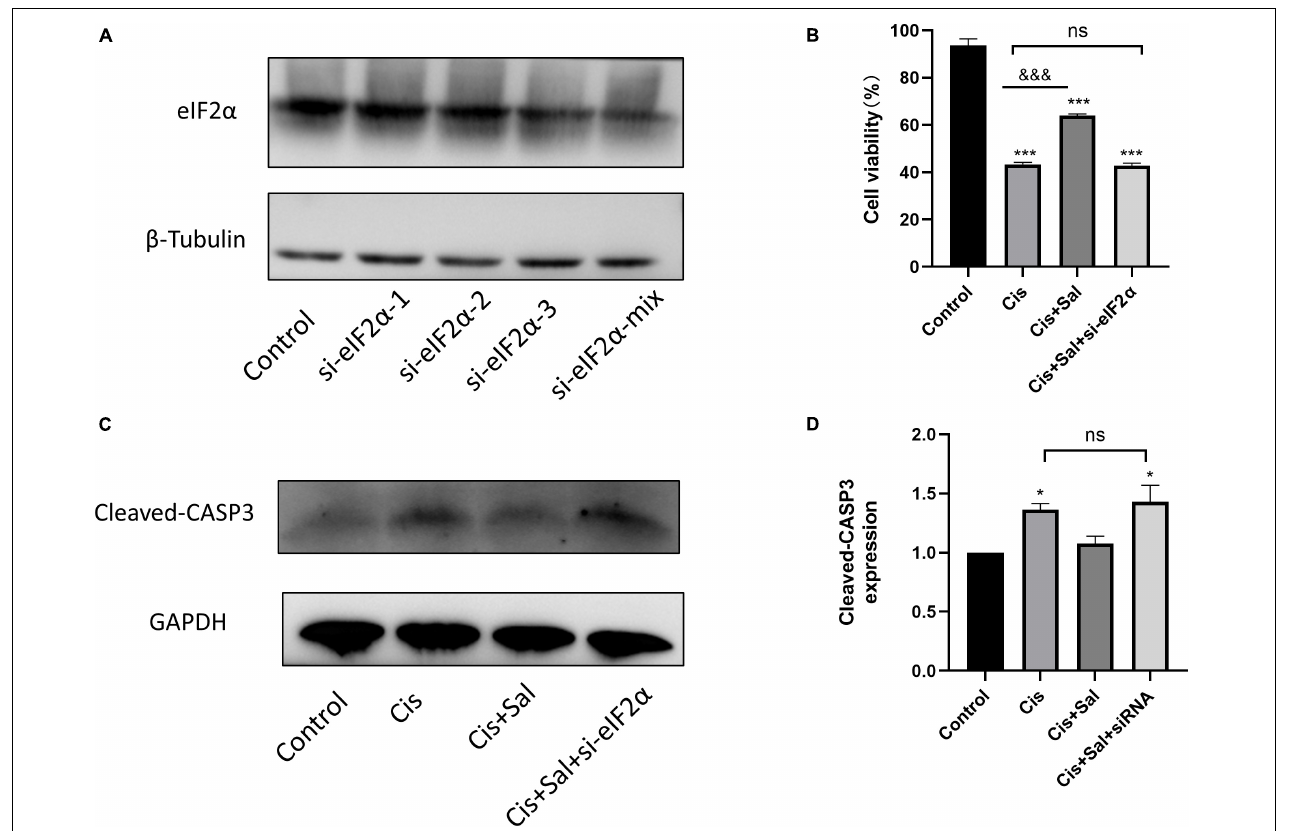
FIGURE 7 | The protective effect of Sal was attributed to eIF2 α in HEI-OC1 cells. (A) Western blotting results showing the expression of eIF2 α transfected with eIF2 α -siRNA. (B) Effect after eIF2 α silencing on cisplatin-induced injury with or without Sal viability in HEI-OC1 cells. (C,D) Effects of knocking down eIF2 α on cisplatin-induced apoptosis. Western blotting results showing the expression of cleaved caspase in the presence of cisplatin or Sal treatment after eIF2 α silencing ( n = 3). Values are presented as mean ± SEM from three independent experiments. * P < 0.05 and *** P < 0.001 vs. the control group; &&& P < 0.001 vs. the cisplatin group. ns, no statistical difference; Sal, salubrinal; Cis,